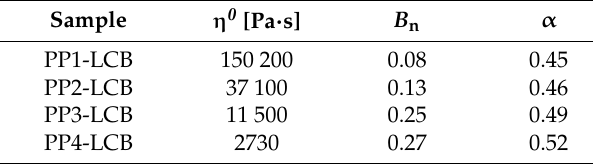
Table 5. Branching number from rheological data.